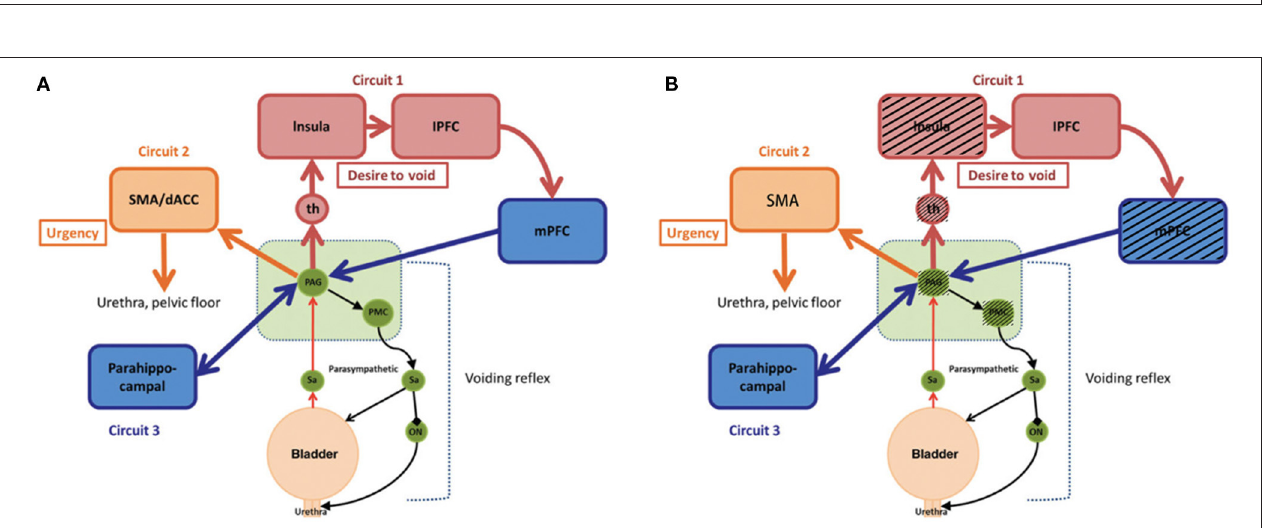
FIGURE 4 | Simple working model of the lower urinary tract control system. (A) Reproduced from De Groat et al. (22). Neural control of the lower urinary tract in healthy people. (B) Modified from (A) . Black shading shows regions active in healthy bladders but not in neobladders, which is a hypothesized difference of mechanism based on small sample size. PAG, periaqueductal gray; PMC, pontine micturition center; th, thalamus; mPFC, medial prefrontal cortex; lPFC, lateral prefrontal cortex; SMA, supplementary motor area; dACC, dorsal anterior cingulate cortex; Sa, Sacral spinal cord; ON, Onuf’s